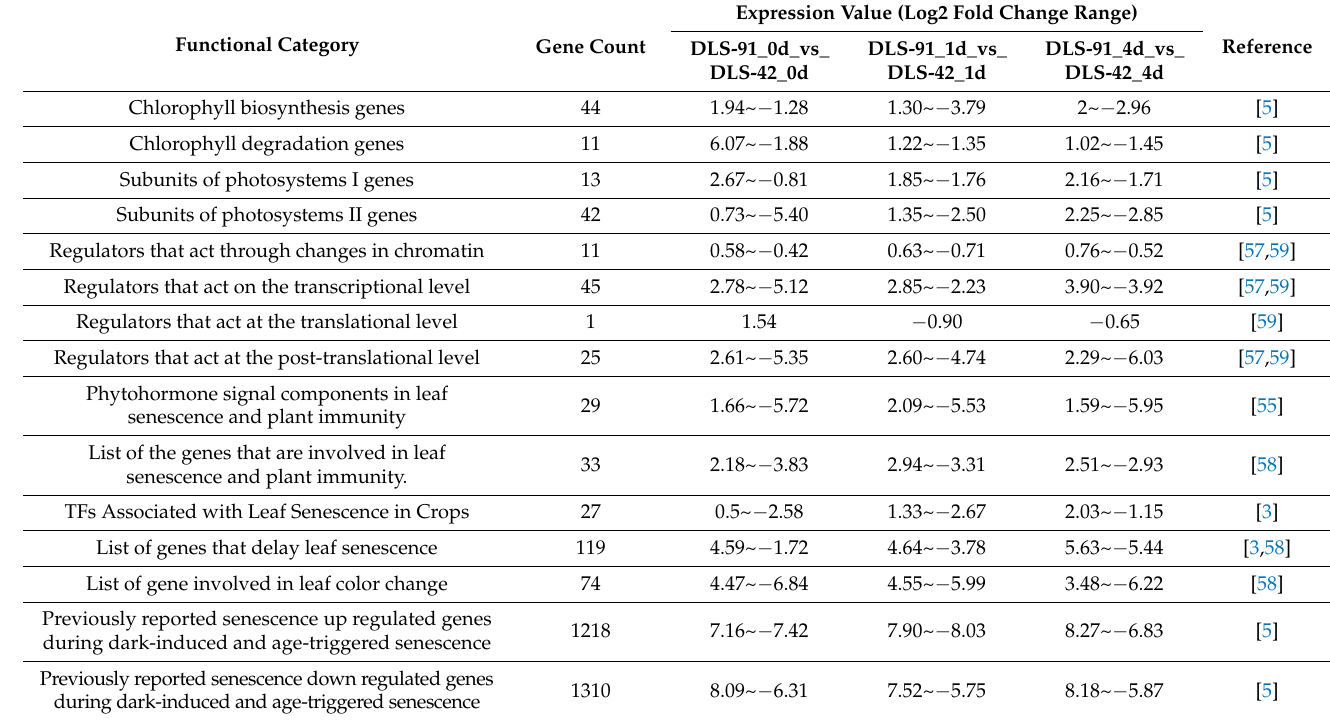
Table 1. Genes identified from the transcriptome data and involved in various functions during leaf